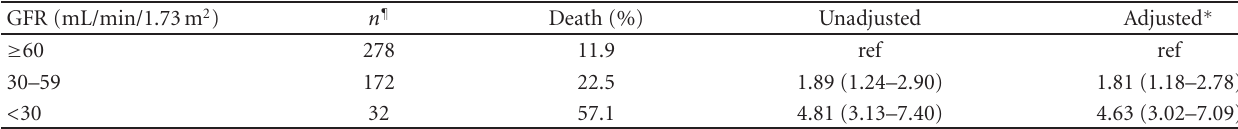
Table 3: Risk ratios and 95% confidence intervals for all-cause mortality based on GFR.